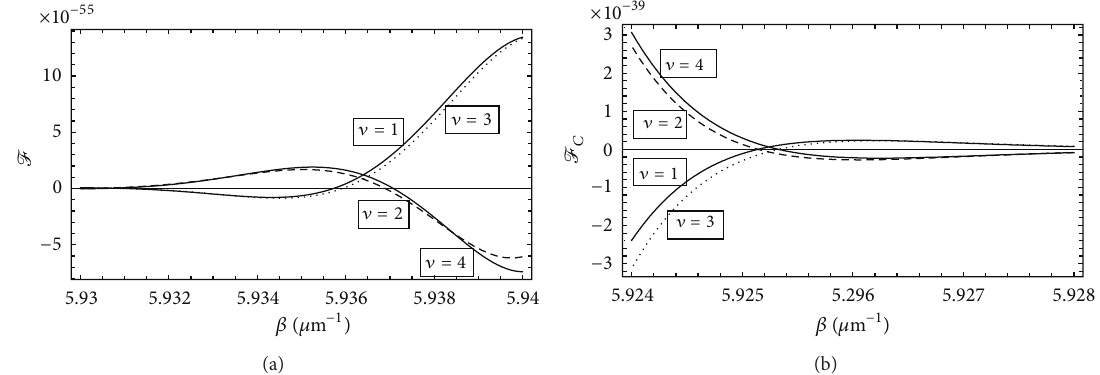
Figure 4: (a) Plot of the dispersion relation for the TE modes corresponding to 𝜓 = 0 ∘ . (b) Plot of the cutoff characteristics for the TE modes corresponding to 𝜓 = 0 ∘ .